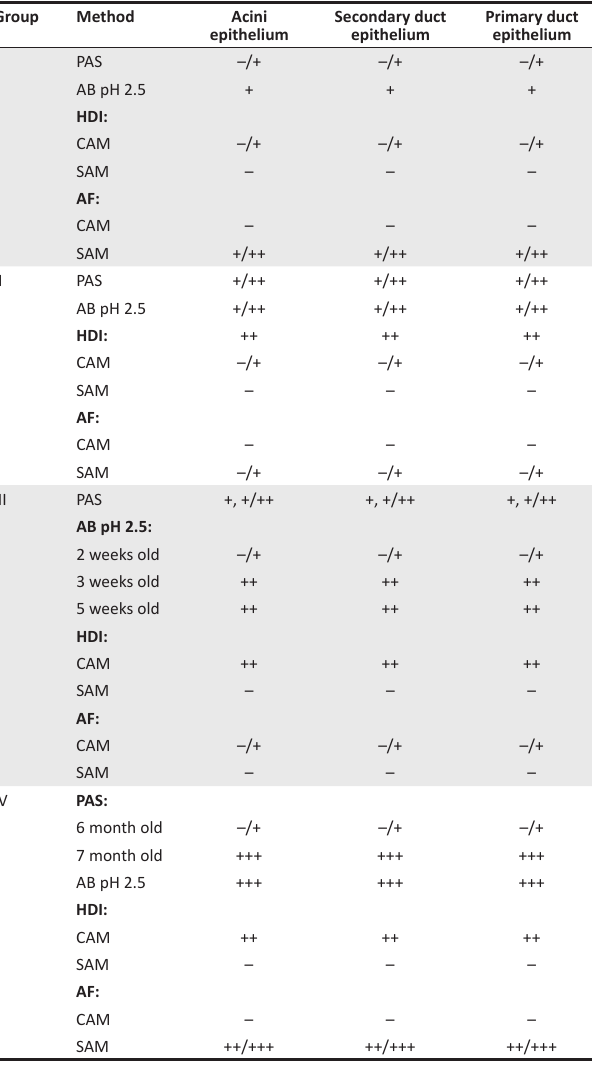
TABLE 1: Histochemical analysis of the lacrimal gland in African black ostrich in the embryonic and postnatal period. Group Method Acini epithelium